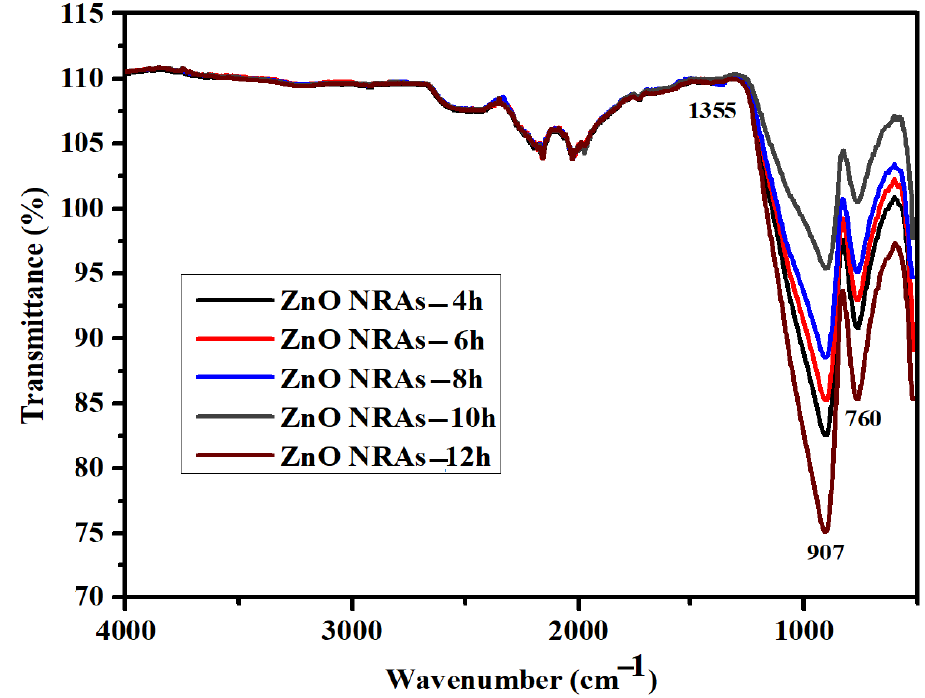
Figure 3. FTIR spectrum of ZNRAs prepared at various hydrothermal growth times.